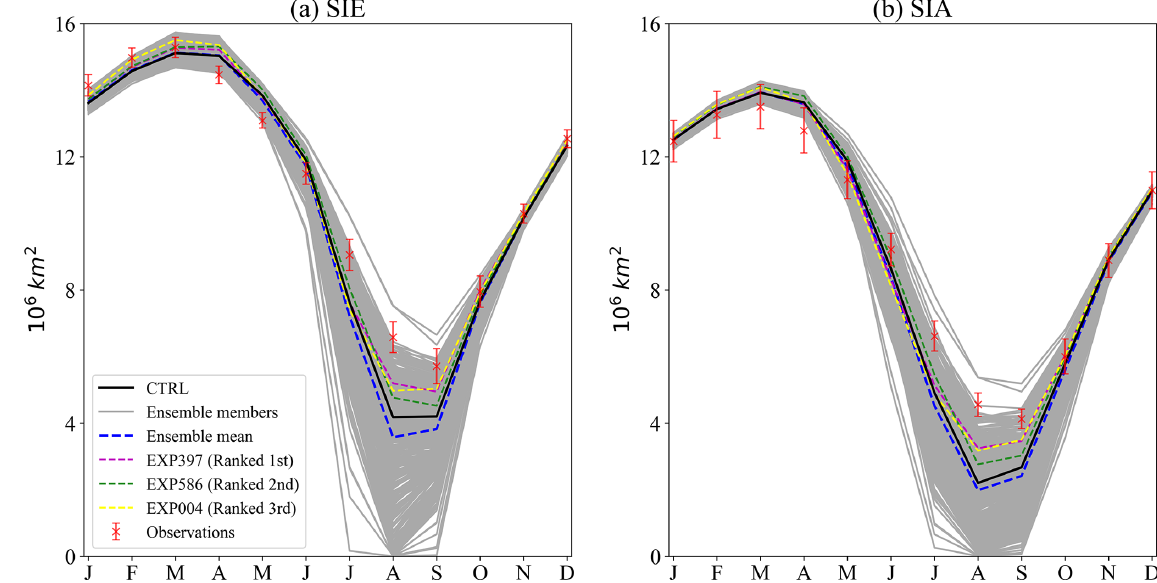
Figure B8. The same as Fig. 2a and b but for the